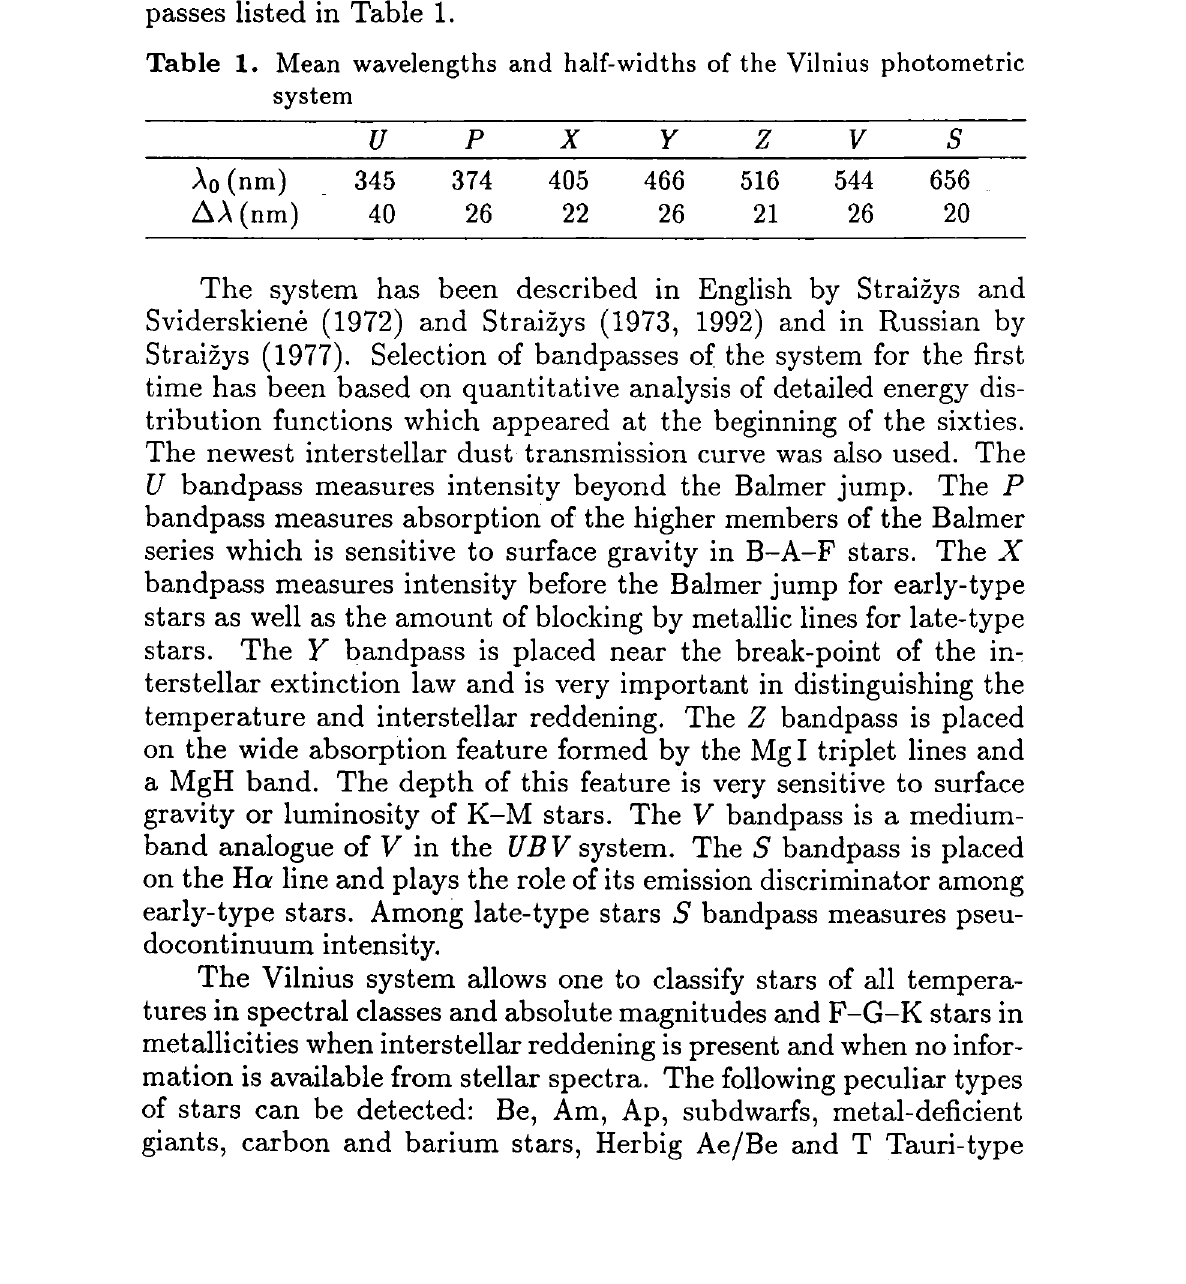
Table 1. Mean wavelengths and half-widths of the Vilnius photometric